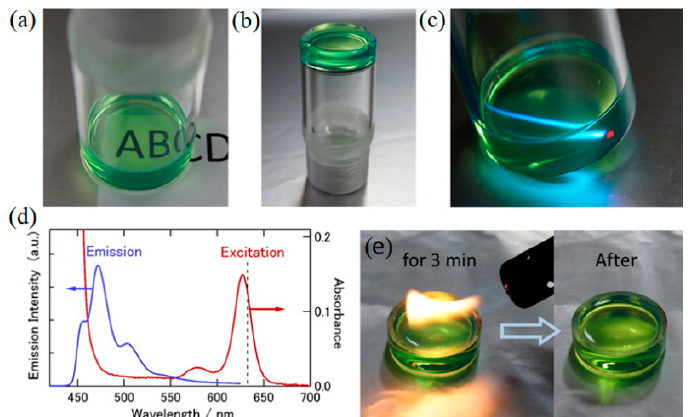
Figure 6. Ionogel photon upconverter prepared using a gelator concentration of 7 g/L. These panels show the ( a ) optical transparency, ( b ) mechanical stability upon inversion, ( c ) upconversion of incident red light (633 nm, ca. 10 mW) to blue light, ( d ) emission and optical absorption spectra, and ( e ) demonstration of the nonflammability by direct exposure to a flame for 3 min. Adopted with permission from [41]. Copyright 2016 American Chemical Society.